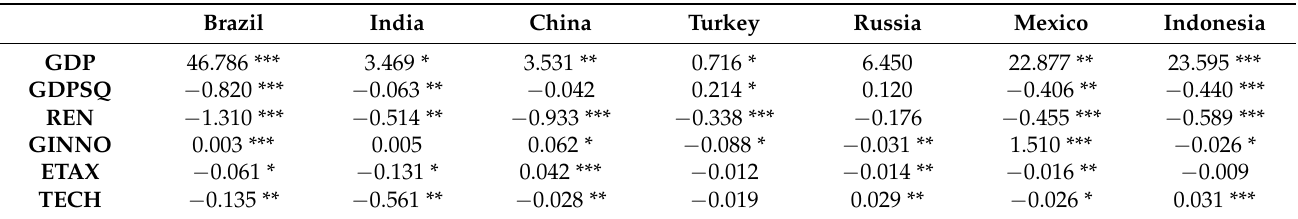
Table 7. Country-specific augmented mean group estimator (Bond and Eberhardt, 2009; Eberhardt and Teal, 2010) robustness